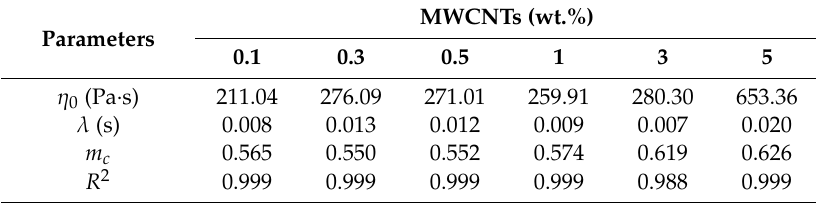
Table 2. Carreau–Winter parameters for master curves at a reference temperature of 130 ◦ C.